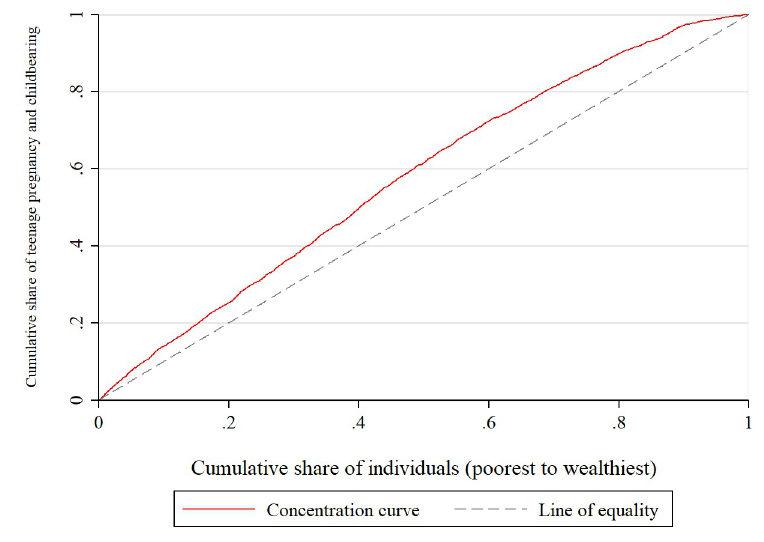
Fig 3. Concentration curve for teenage pregnancy and childbearing (Pooled data). Constructed by authors from MDHS 2004, 2010, 2015–16.